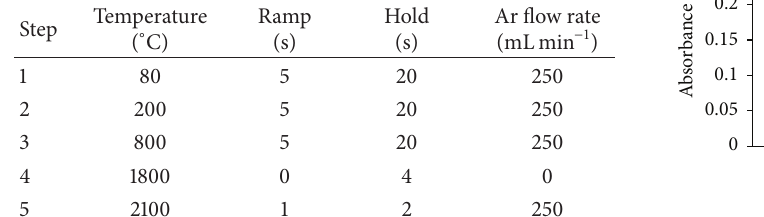
Table 1: Heating program for determination of zinc. Step